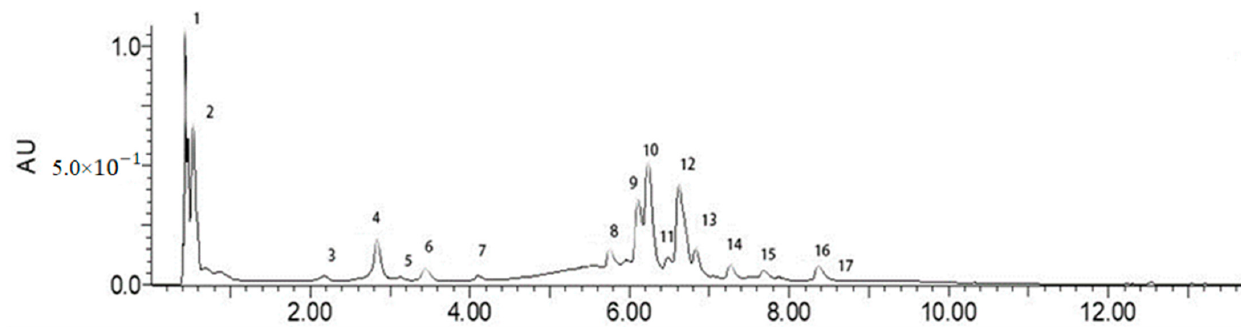
Figure 2. UPLC chromatograms (280 nm) of phenolic extracts from burdock root powder.